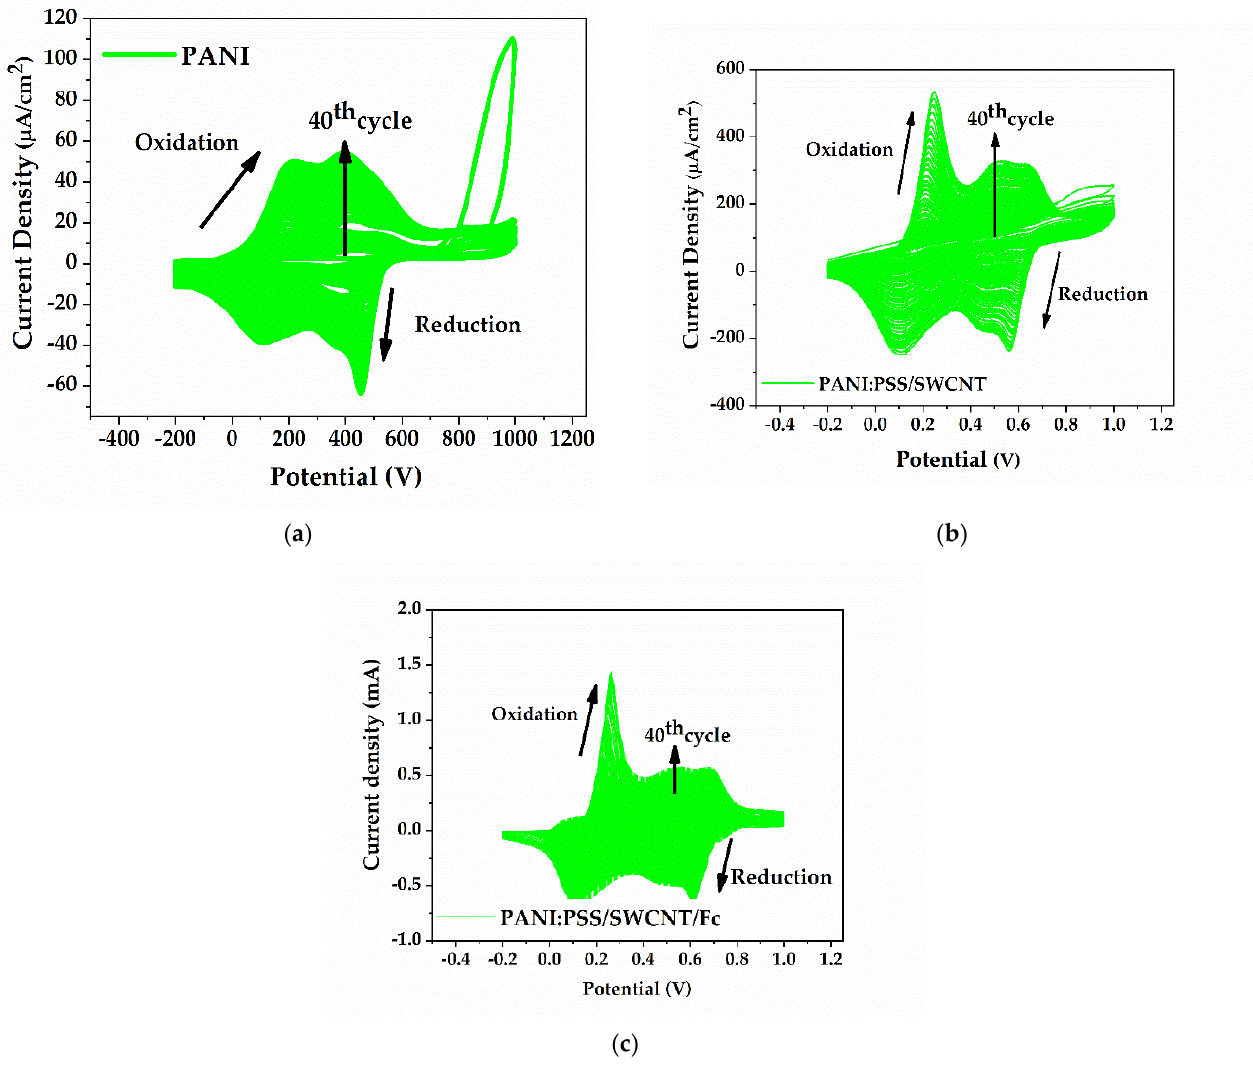
Figure 7. Cyclic voltammograms during formation of ( a ) PANI, ( b ) PANI:PSS/SWCNT, ( c ) PANI:PSS/SWCNT/Fc; For each CV measurement, n = 40 cycles were taken from − 0.2 V to 0.9 V vs. Ag/AgCl with a scan rate of 50 mV/s.